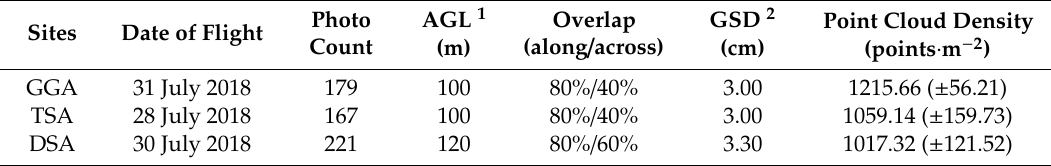
Table 1. Basic information of remote sensing acquisition of UAS images. Sites Date of